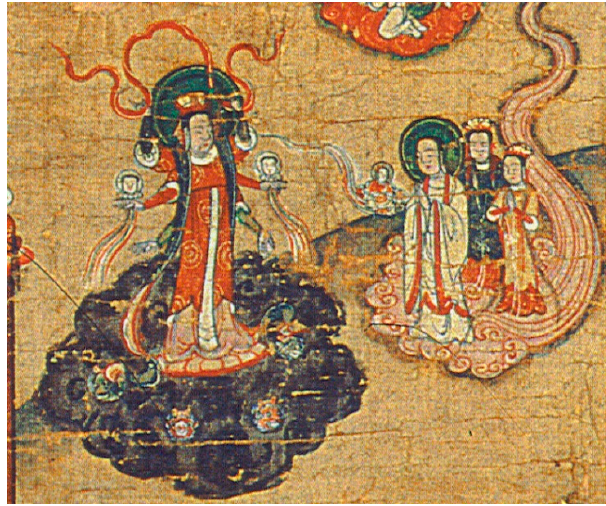
Figure 5. Virgin of Light and Mani (Yoshida and Furukawa 2015, Plate 9).